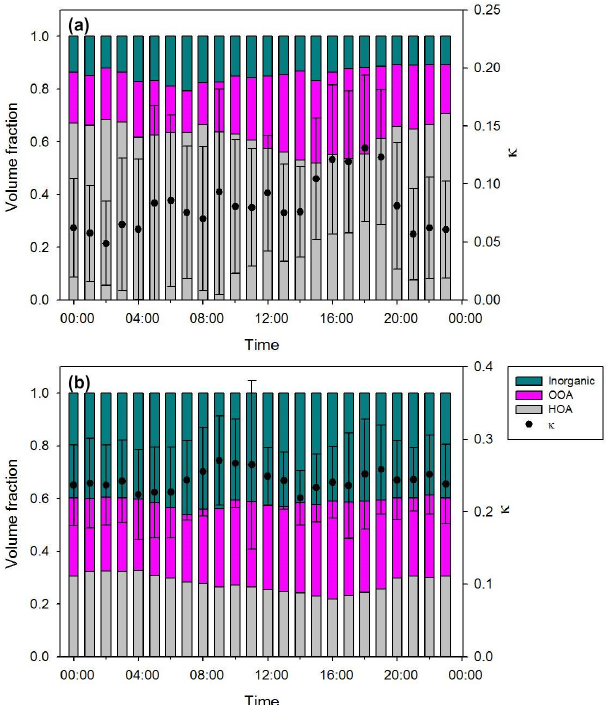
Figure 7. Diurnal variation in κ values ( κ HTDMA ) and chemical composition of (a) 50nm and (b) 150nm particles.